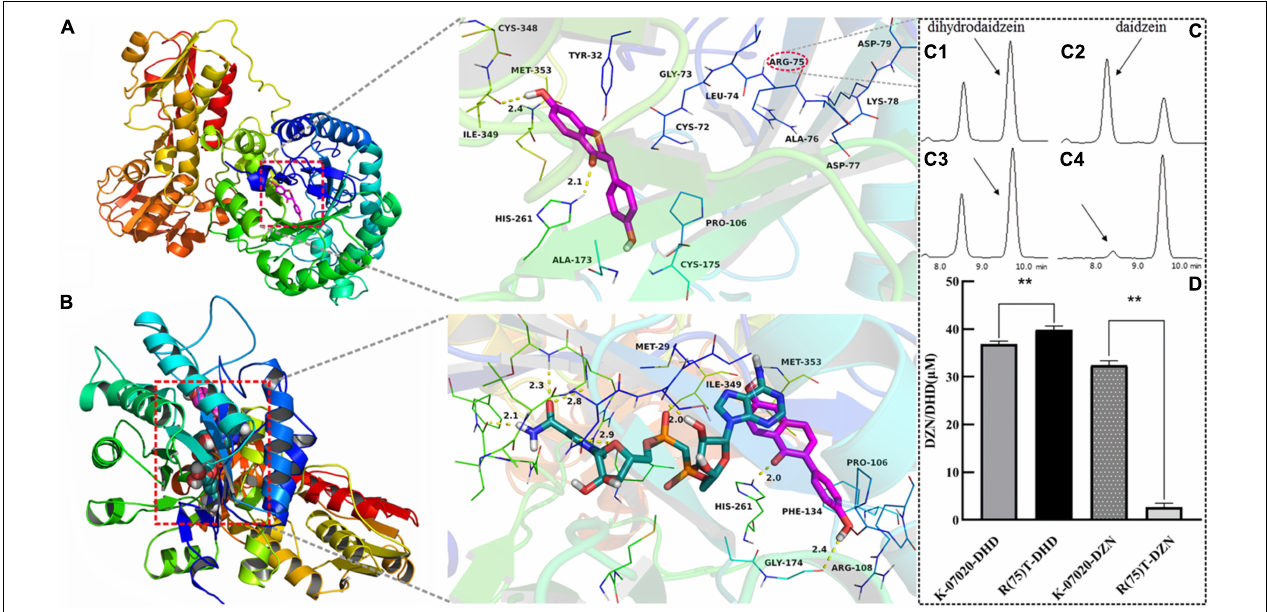
FIGURE 5 | Analysis of oxidase key functional loci in K-07020. (A) DHD was docked into the binding site of K-07020. (B) DZN and NADH were docked into the binding site of K-07020. (C) Function detection of R(75)T K-07020 mutation by HPLC. (C1,C2) Respectively denote reductase and oxidase functions of K-07020; (C3,C4) respectively denote reductase and oxidase functions of R(75)T K-07020 mutation; (D) quantitative detection of K-07020 and R(75)T K-07020 mutation, DHD and DZN denote reductase and oxidase function detection, respectively, ** represents a P -value less than 0.01. The amino acid at position 75 (Arg) was identified as the key amino acid for DHD oxidase function in K-07020.